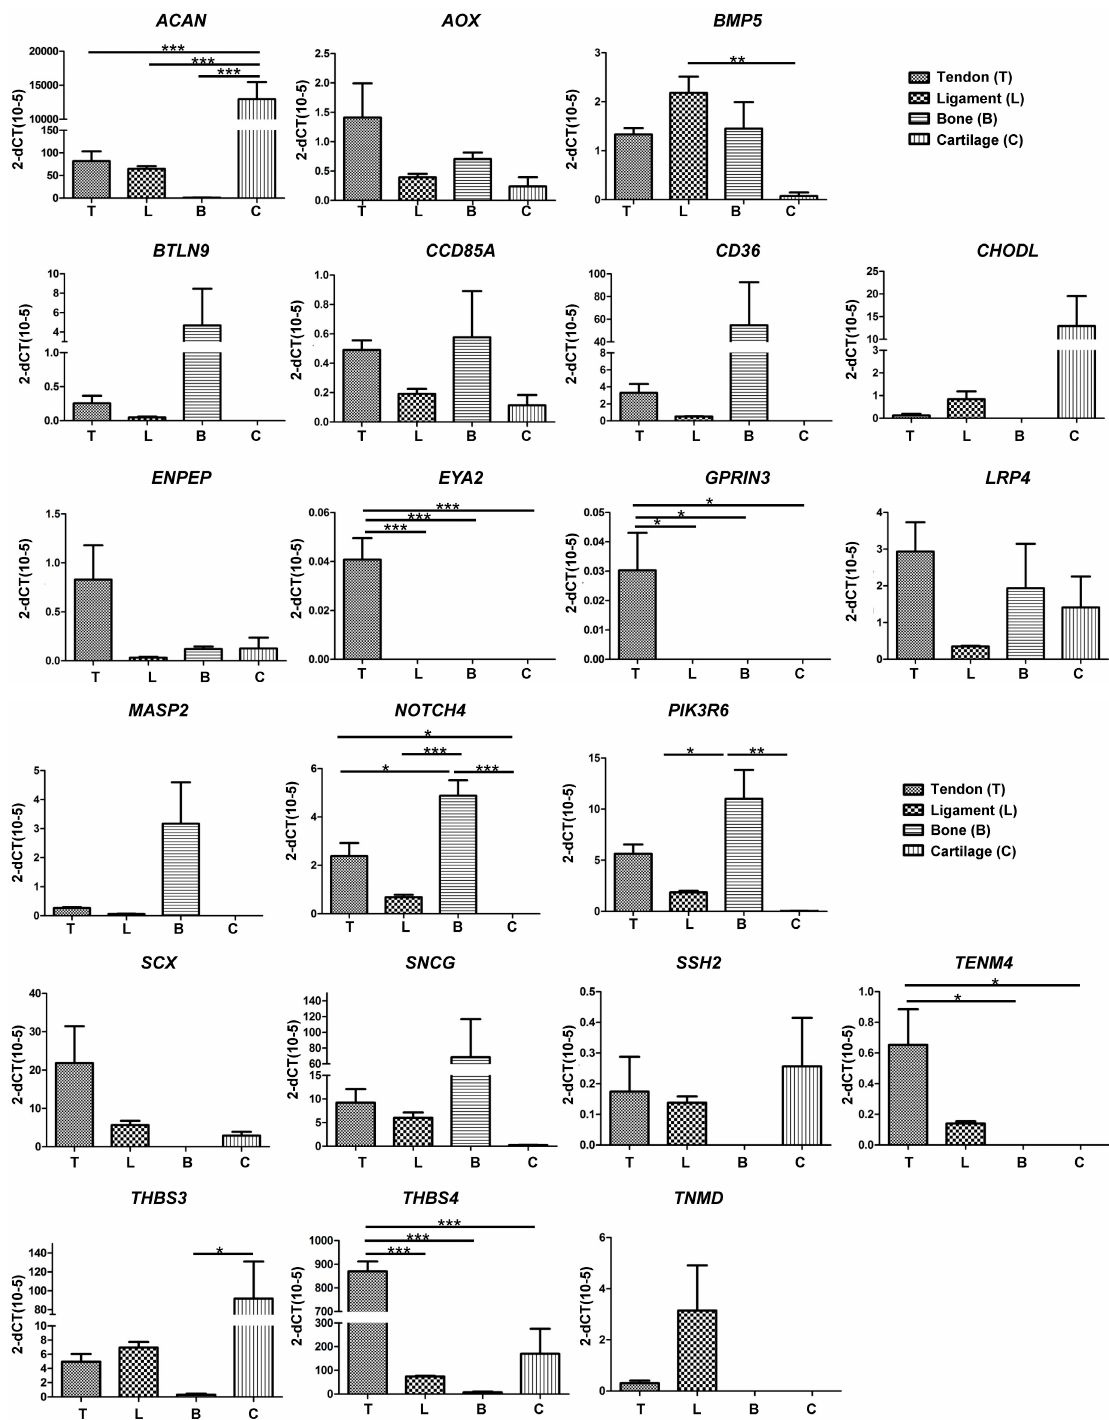
Figure 3. RT ‐ qPCR analysis of candidate genes identified using RNA ‐ seq. Data were normalized to 18S and presented as 2 −Δ C T . * p < 0.01 as determined using one ‐ way ANOVA and Tukey post ‐ hoc test. Data are representative of three separate reactions performed using RNA isolated from three horses.